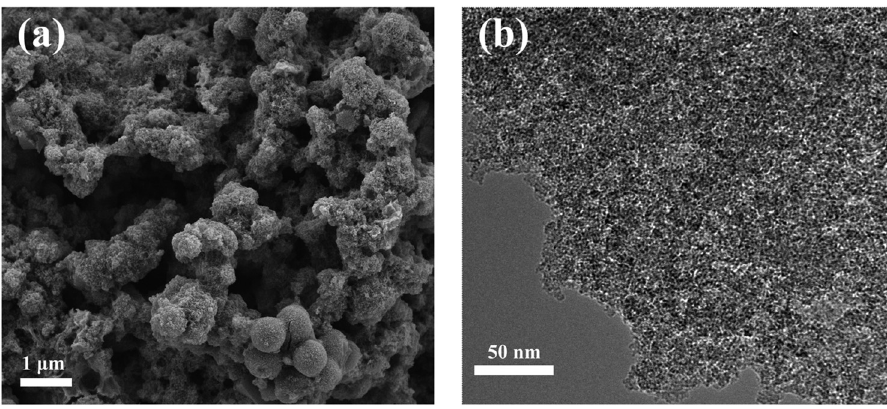
Figure 4: ( a ) SEM and ( b ) TEM images of HCP - TPB.